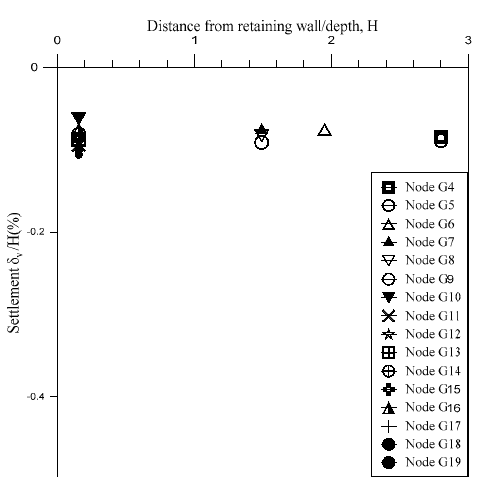
Figure 16. Ground surface settlement versus distance from the retaining wall.